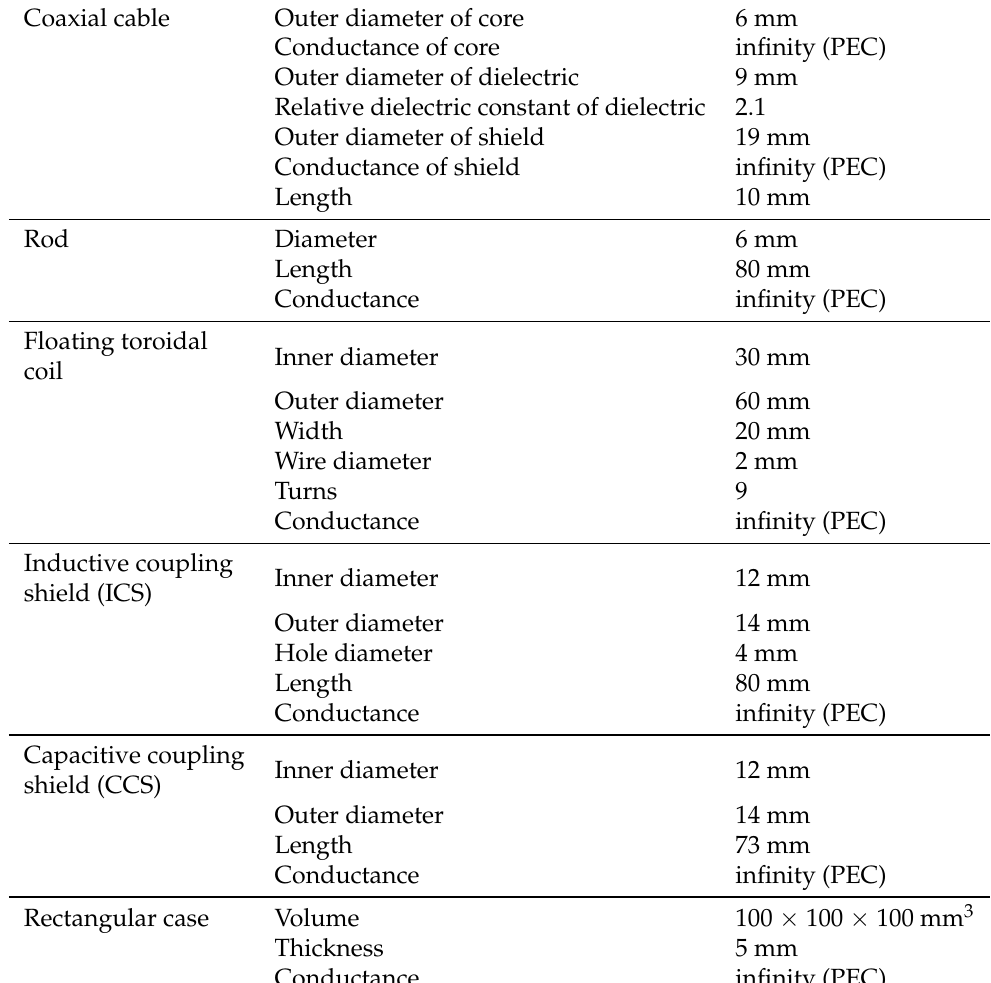
Table 1. Dimensions used in the three-dimensional electromagnetic wave simulation. PEC: perfect electric